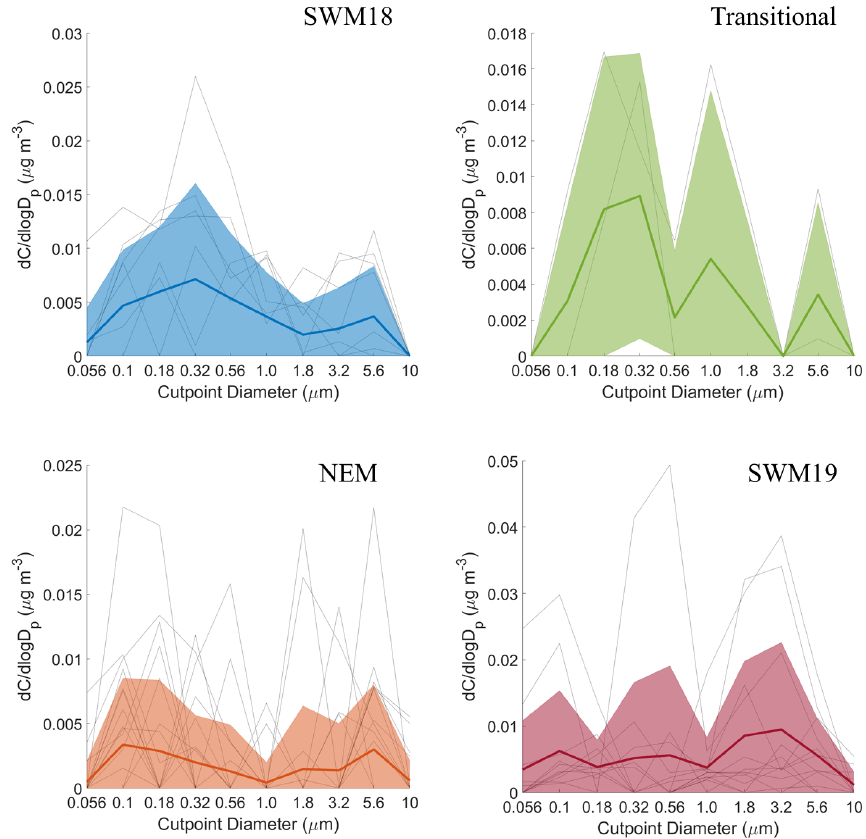
Figure 7. Same as Fig. 6 but for